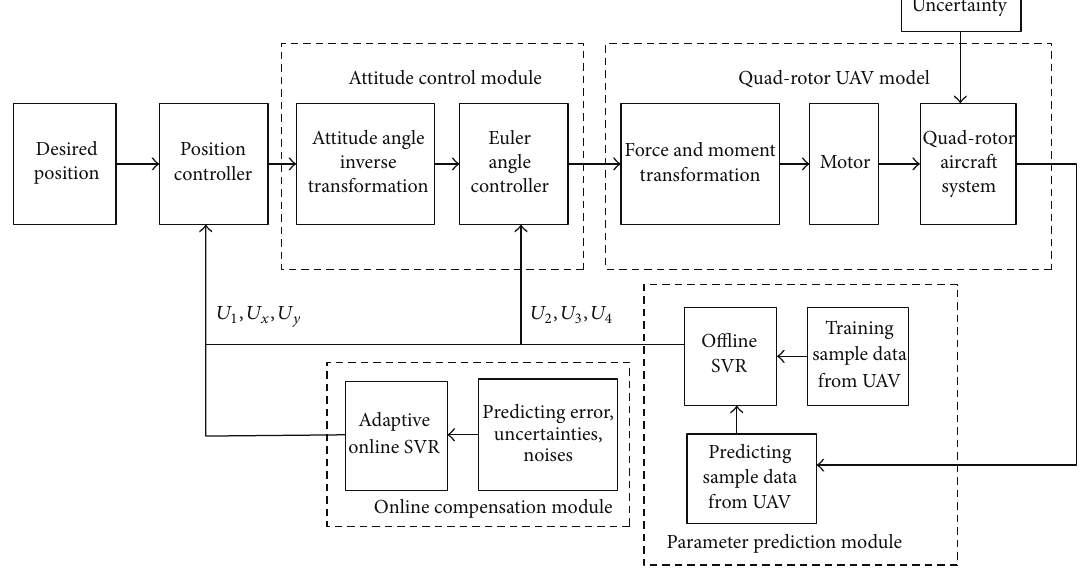
Figure 3: Position control system structure for quad-rotor